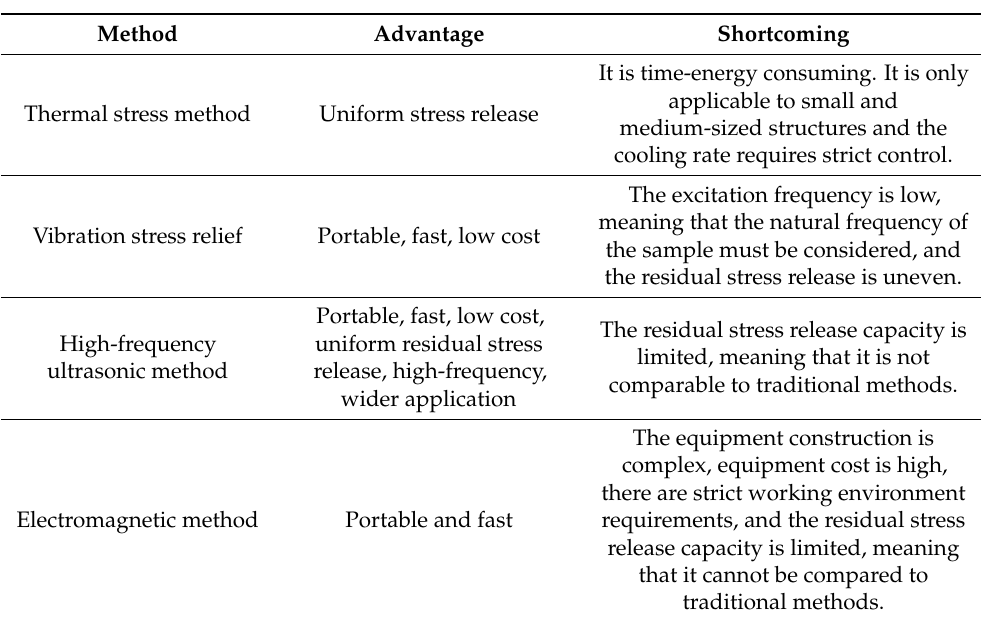
Table 1. Comparison of advantages and disadvantages.